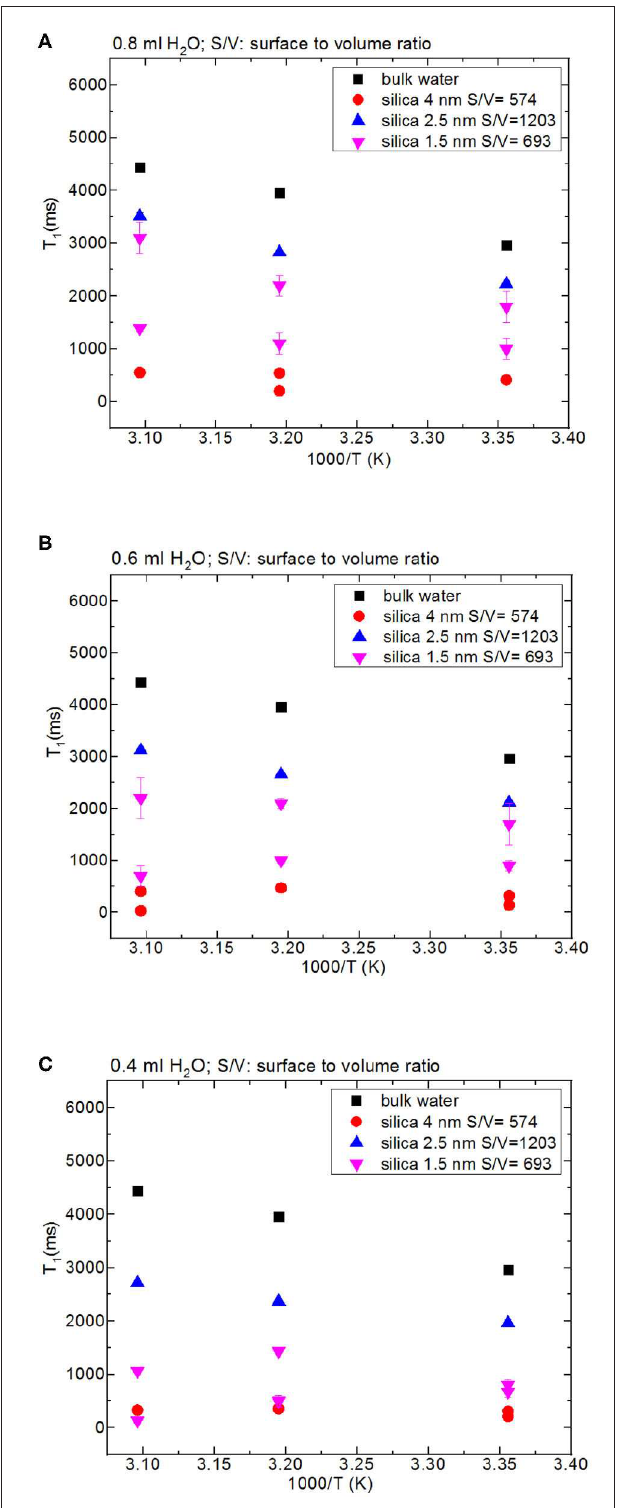
FIGURE 2 | Comparison of T 1 values of bulk water and water mixed with nanoporous silica where the variables are pore diameter of nanoporous silica with the amount of 150mg (silica-4.0nm, silica-2.5nm, silica-1.5nm), temperature (298, 313, 323K) and volume of water [0.8ml water (A) , 0.6ml water (B) , 0.4ml water (C)